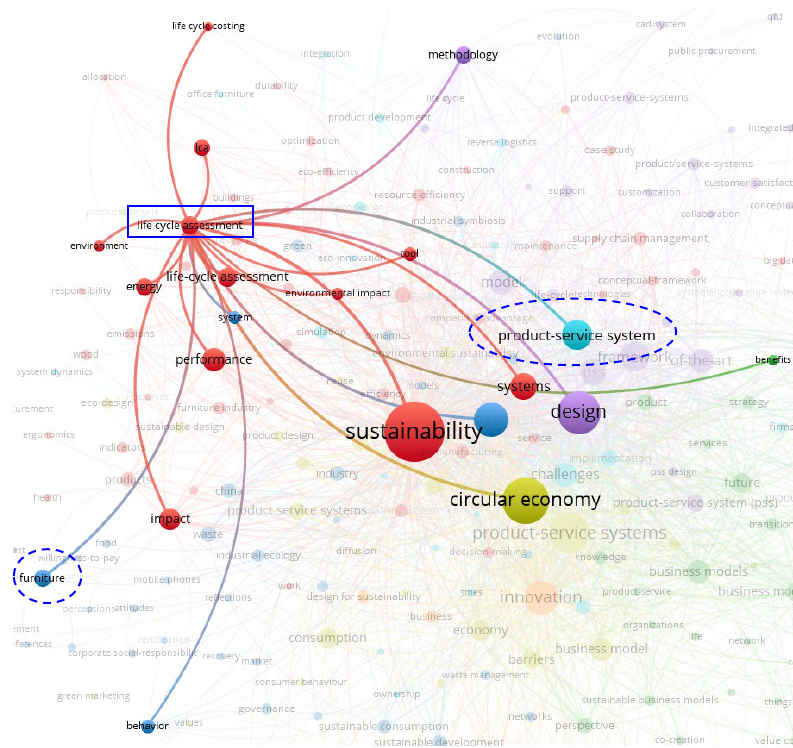
Figure 3. Keywords co-occurrence visualization of furniture and PSSs in the context of CE and sus- tainability highlighted from the Figure 2 (generated by